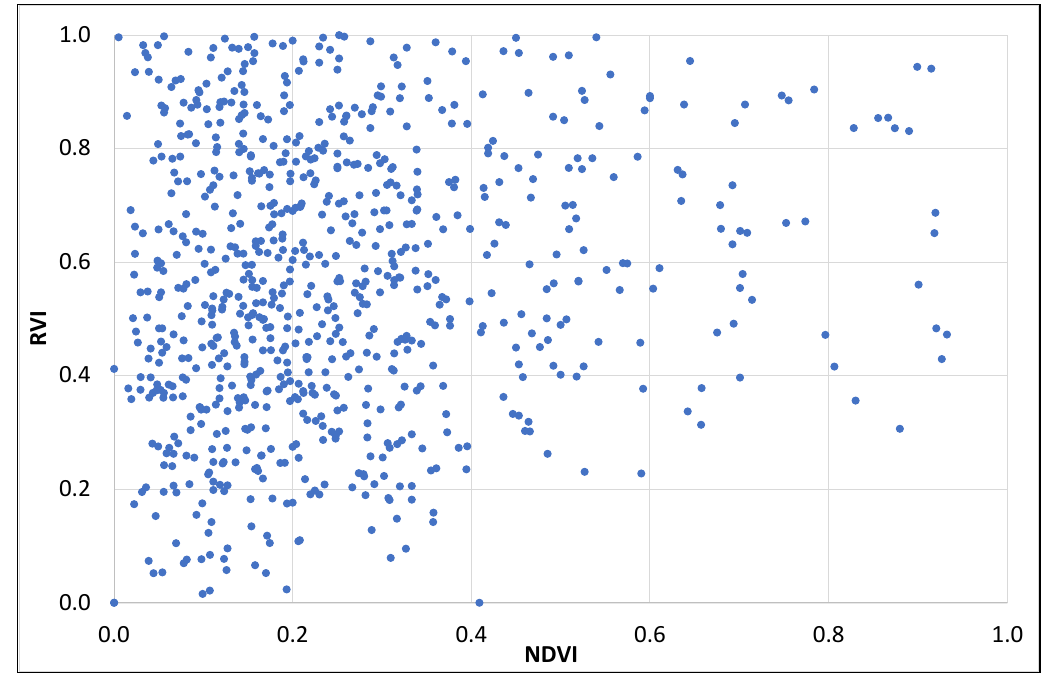
Figure 5. Scatterplot of NDVI and RVI values over 1000 random points in the case study area. In light of the above, monthly RVI and NDVI during the period from May 2019 to May 2020 were extracted from the Sentinel Hub service and interpreted. Monthly RVI results over the case study area are shown in Figure 6-left, while Figure 6-right shows the results of the NDVI (whereas a–l in both figures refers to months starting from May 2019). Higher RVI values that might correspond to vegetated areas are highlighted with a red colour in Figure 6-left, while the dark-green colour in Figure 6-right shows vegetation at the optical products. Examining Figure 6, it is evident that optical Sentinel-2 images (NDVI) can depict the phenological changes of the vegetation very well over the area of interest throughout the year. Indeed, during the summer period (June–August 2019), the NDVI is decreased compared to other periods. In contrast, the interpretation of the RVI is still problematic (Figure 6-left). However, some increase in vegetation (red colour) is evident during the months Dec. 2019 to Feb. 2020 (Figure 6-left, h–j). This increase of vegetation is also visible to optical products as well (Figure 6-right, h–j), indicating that a pattern over vegetated areas can be extracted from both Sentinel-1 and -2